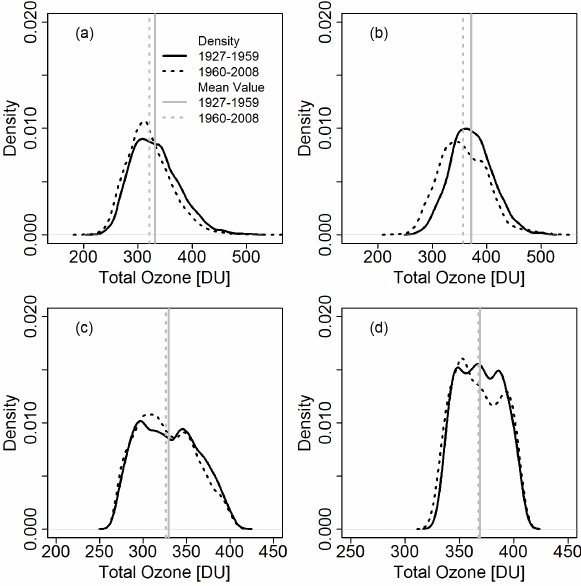
Fig. 8. Thresholds for extreme high (EHOs) and low (ELOs) total ozone and monthly means of total ozone over Arosa, for the periods 1927–1959 and 1960–2008. a second period of about 30 years with less frequent EHOs.